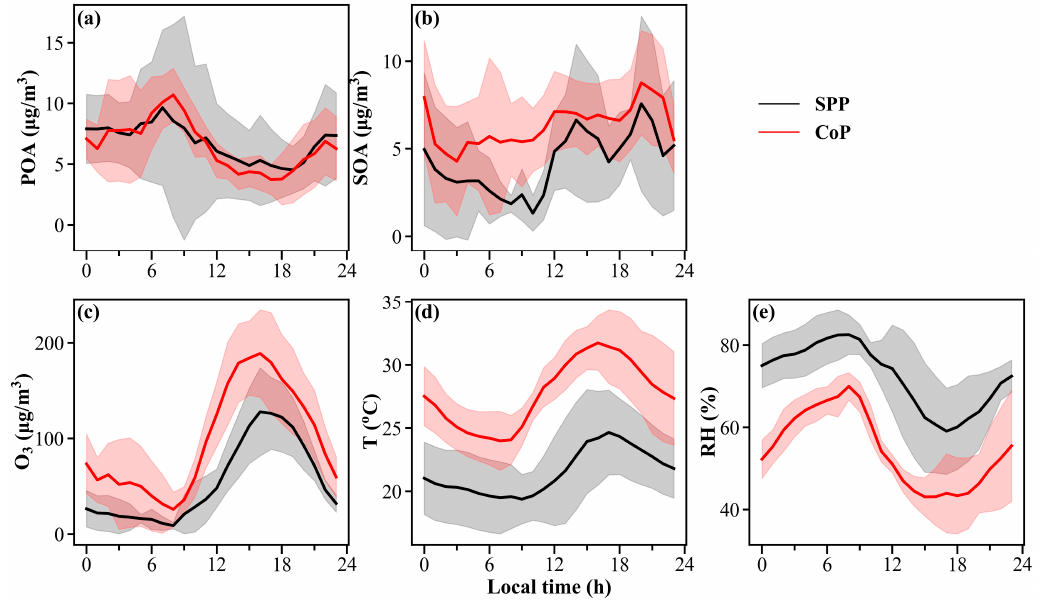
Figure 5. Diurnal patterns of different carbonaceous aerosols ( a , b ), O 3 ( c ), T ( d ) and RH ( e ) in different pollution episodes. The solid line and shaded areas are the mean and standard deviation, respectively.